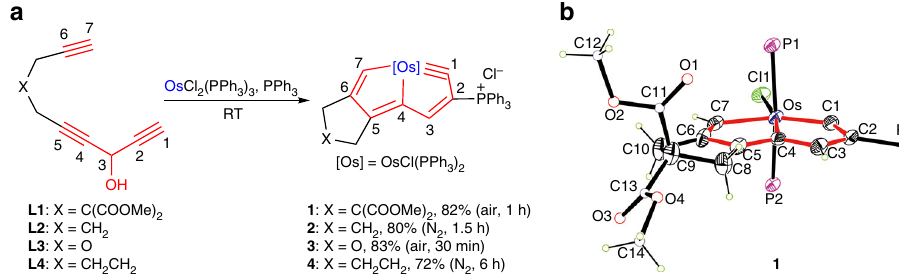
Fig. 2 Synthesis of CCC-type osmium chelates from triynes. a Triynes as ligand precursors to access CCC-type chelates with three metal – carbon σ bonds. b X-ray structure of the cation of chelate 1 drawn with 50% probability (phenyl groups in PPh 3 are omitted for clarity). Selected bond distances (Å) and angles (deg): Os – C1 1.840(7), Os – C4 2.108(7), Os – C7 2.040(8), C1 – C2 1.406(10), C2 – C3 1.394(10), C3 – C4 1.395(9), C4 – C5 1.390(10), C5 – C6